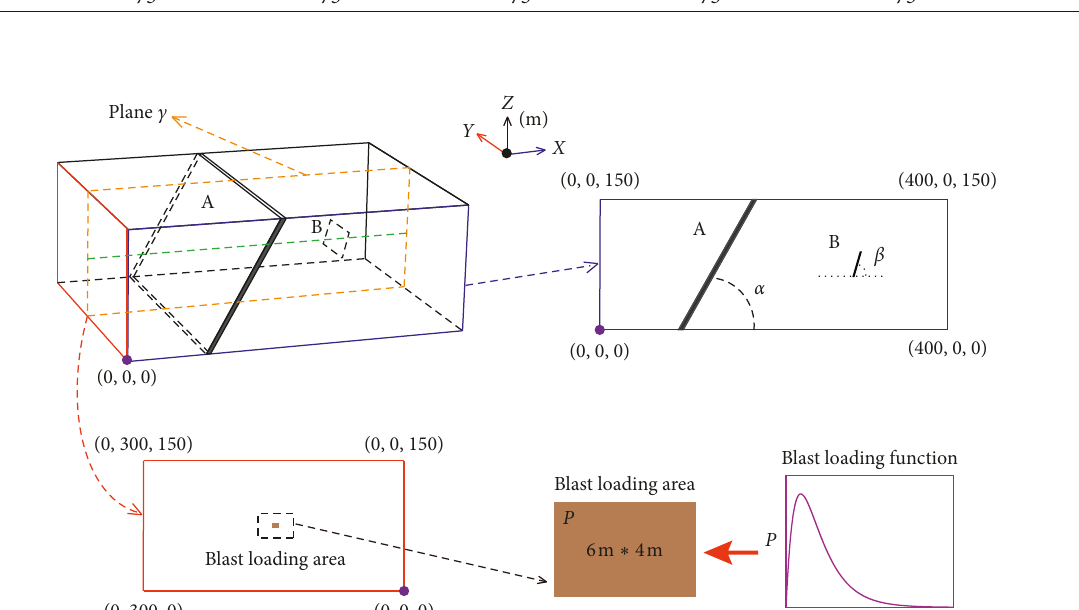
Figure 1: Schematic geometry of the designed model. Two faults (A and B) with different dip angles ( α and β ) are installed in the model area. A blast loading function (purple curve) is applied at a rectangle area which is located on the left wall of the model (indicated by the red lines), with a range of 6 × 4 � 24m 2 (indicated by the brown area).